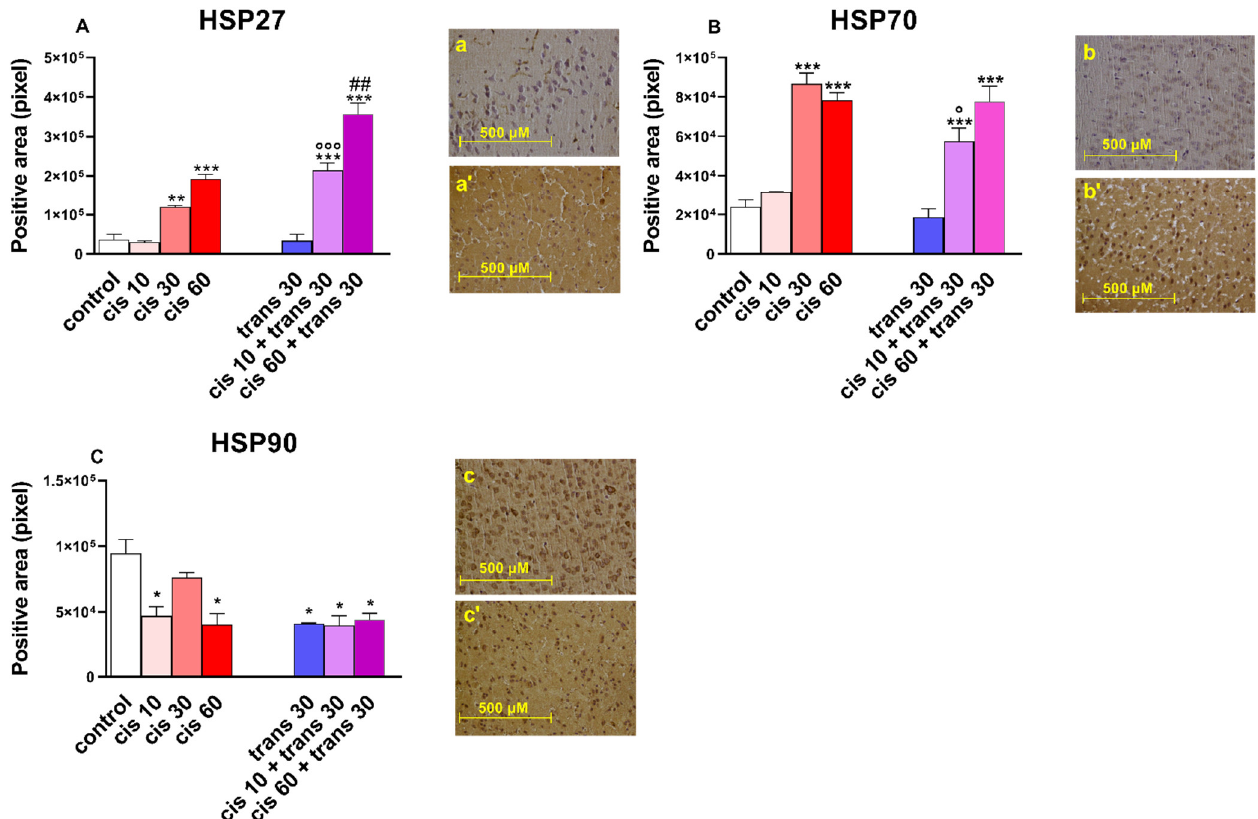
Figure 5. ( A ) Quantification and comparison of HSP27 positive areas in controls versus 4-4 (cid:48) -DMAR-mice (( ± ) cis 10, ( ± ) cis 30, ( ± ) cis 60, ( ± ) trans 30, ( ± ) trans 30 + ( ± ) cis 10, ( ± ) trans 30 + ( ± ) cis 60). Comparison of ( ± ) cis 60 versus ( ± ) trans 30 + ( ± ) cis 60). Comparison of ( ± ) cis 10 versus ( ± ) trans 30 + ( ± ) cis 10 [ ◦ ]. Representative image (light microscopy, 40 × ) of HSP27 immunostaining (brown areas) in the cortex of mice receiving 4-4 (cid:48) -DMAR (( ± ) cis 60, a’) and controls (a). ( B ) Quantification and comparison of HSP70 positive areas in controls versus 4-4 (cid:48) -DMAR-mice (( ± ) cis 10, ( ± ) cis 30, ( ± ) cis 60, ( ± ) trans 30, ( ± ) trans 30 + ( ± ) cis 10, ( ± ) trans 30 + ( ± ) cis 60). Comparison of ( ± ) cis 10 versus ( ± ) trans 30 + ( ± ) cis 10 [ ◦ ]. Representative image (light microscopy, 40x) of HSP70 immunostaining (brown areas) in the cortex of mice receiving 4-4 (cid:48) -DMAR (( ± ) cis 60, b’) and controls (b). ( C ) Quantification and comparison of HSP90 positive areas in controls versus 4-4′-DMAR-mice ((±) cis 10, (±) cis 30, (±) cis 60, (±) trans 30, (±) trans 30 + (±) cis 10, (±) trans 30 + (±) cis 60). Representative image (light microscopy, 40×) of HSP90 immunostaining (brown areas) in the cortex of mice receiving 4-4′-DMAR ((±) cis 30, c’) and controls (c). * p < 0.05, ** p < 0.01 and *** p < 0.001 different from control; ° p < 0.05 and °°° p < 0.001 different from (±) cis 30; ## p < 0.001 different from (±) cis 60.